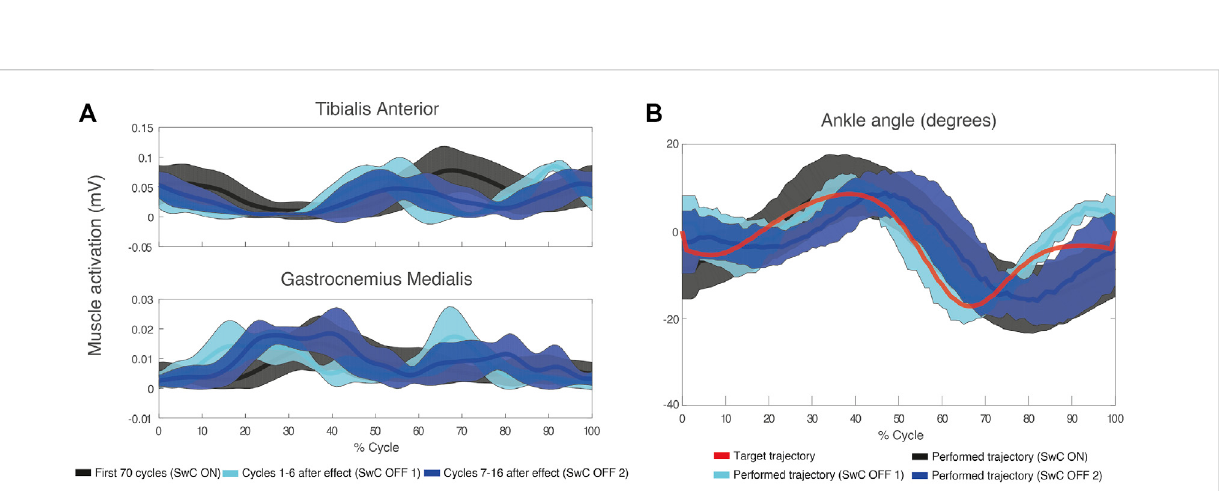
FIGURE 8 (A) Mean (thick lines) and standard deviation (shaded areas) of EMG envelopes from the tibialis anterior and gastrocnemius medialis of a representative subject (ID 09) during SwC trial. (B) Target and performed ankle trajectory during the three speci fi c phases of SwC trials: SwC ON ( fi rst 70 cycles), SwC OFF 1 ( fi rst stage after removing SwC torque), and SwC OFF 2 (second stage after removing SwC torque). Positive angles indicate dorsi fl exion and negative angles indicate plantar fl